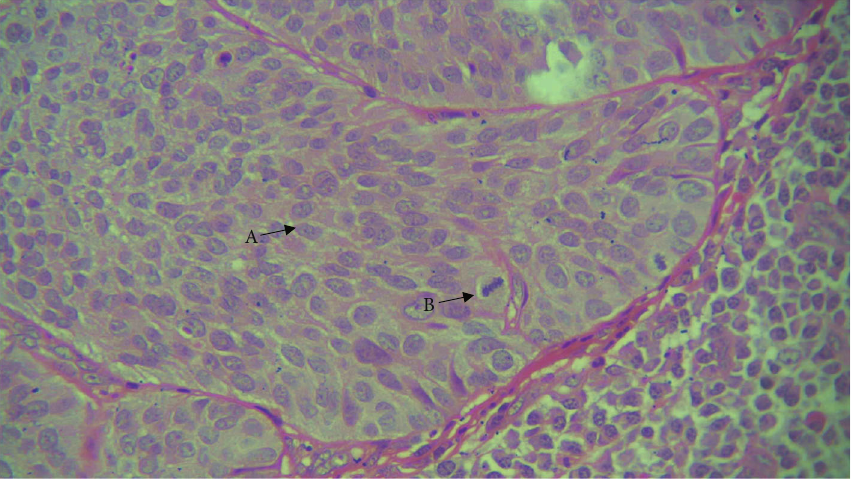
Figure 4: 40 × view. A: basaloid cells; and B: mitotic fi gure.